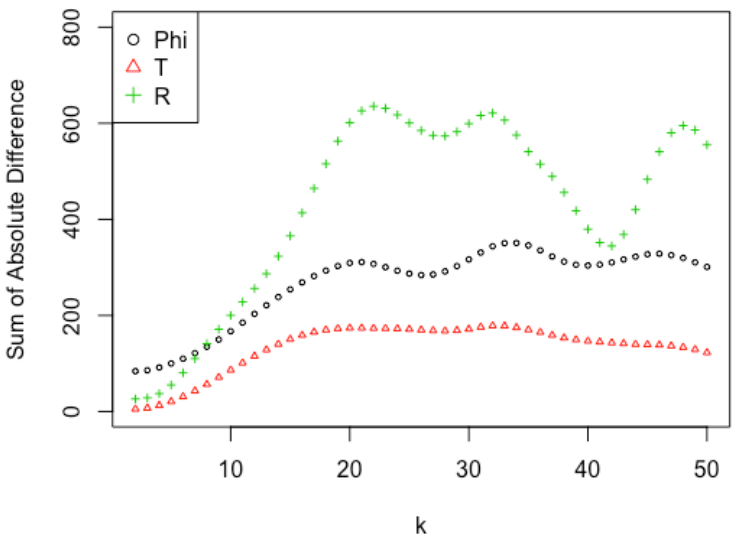
Figure 4. Plot of the difference between estimators and true value when switching order 1 and k ( k = 2,3, . . . ,50).